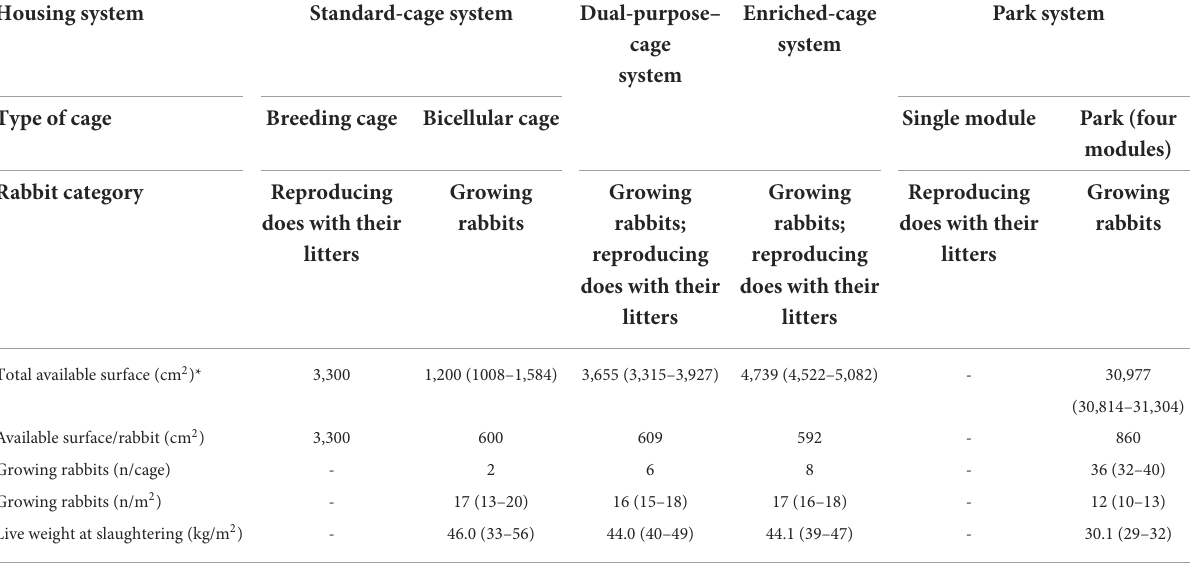
TABLE 1 Housing systems and cage size in the farms subjected to the on-farm welfare evaluation in reproducing does with their litters and in growing rabbits. Housing